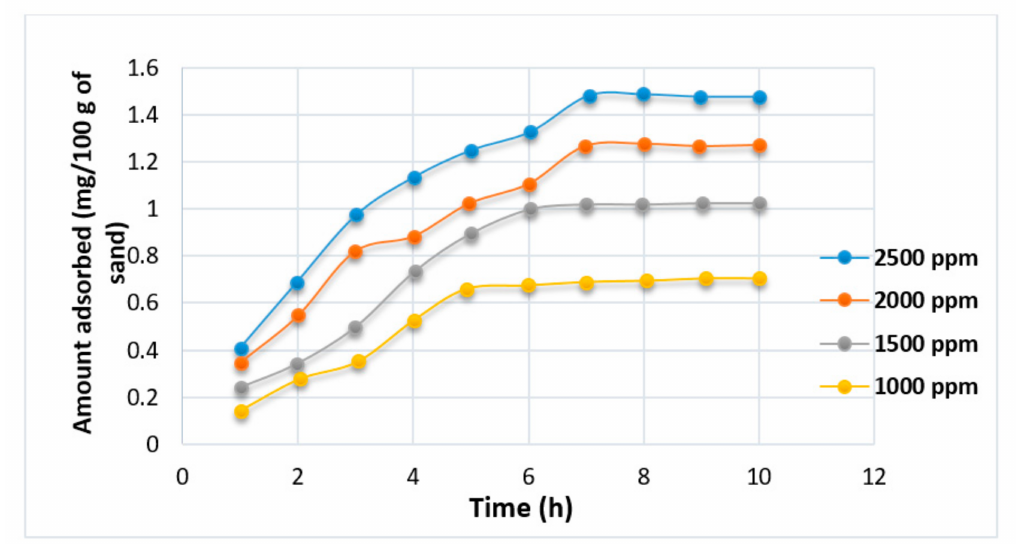
Figure 19. E ff ect of adsorption on HPAM. Reprinted and modified from